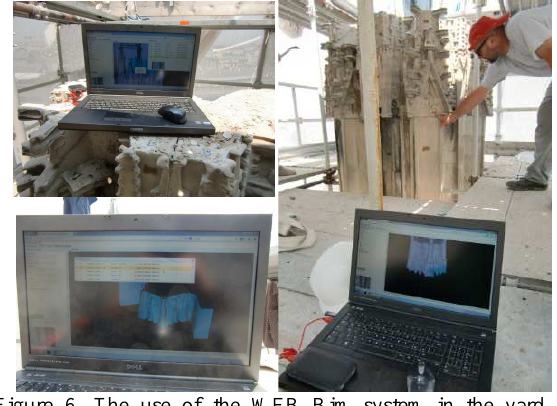
Figure 6. The use of the WEB Bim system in the yard as support for the disassembly of the oldest spire of the Milan